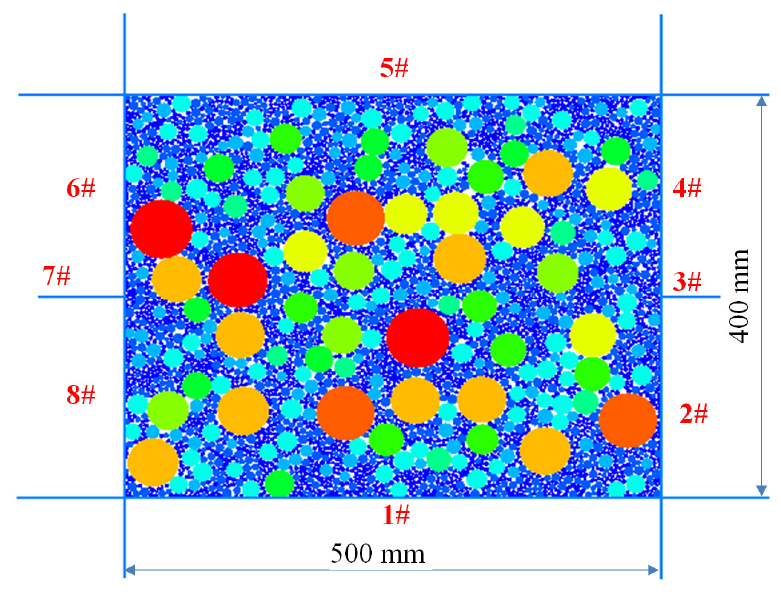
Figure 7. Numerical model of the direct shear test of an SRM sample.